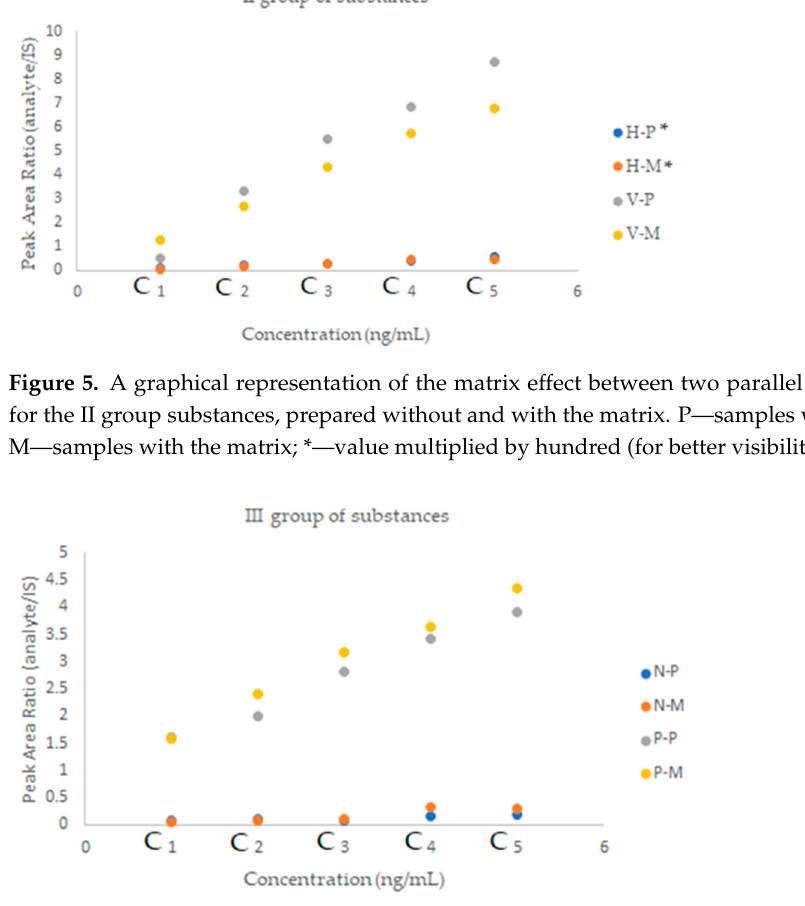
Figure 6. A graphical representation of the matrix effect between two parallel calibration curves for the III group substances, prepared without and with the matrix. P—samples without the matrix, M—samples with the matrix.